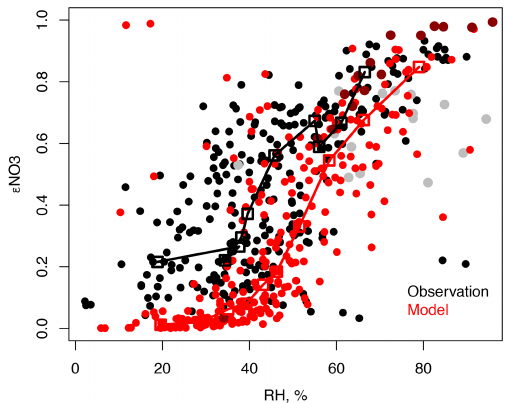
Figure 5. Modeled and observed ε NO 3 as a function of RH below 1.5km for the domain in Fig. 3. Median ε NO 3 as a function of size- binned RH, with each bin of equal size, is overlaid (squares). The haze buildup (24–26 May) is shown in gray for the observations and dark red for the model.